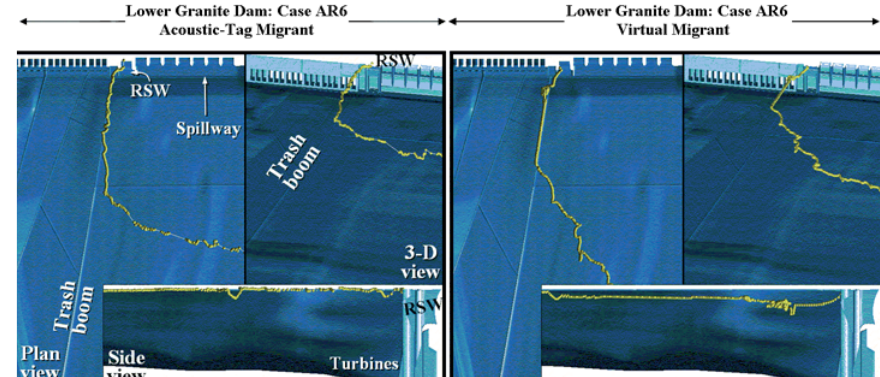
Fig. 4. Comparison of 3-D tagged (left) and virtual (right) emigrant tracks for Lower Granite Dam 2003 RSW. Dam operation described in Goodwin et al. (2006). CFD model depiction of forebay hydrodynamic pattern in Fig. 5. Acoustic-tag emigrant track provided by U.S. Geological Survey (Cash et al.,